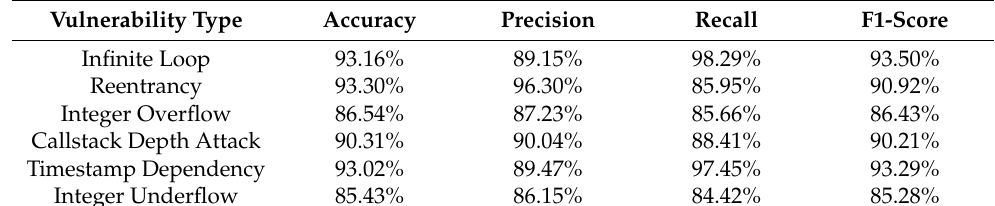
Table 3. Test results for the six different vulnerabilities.